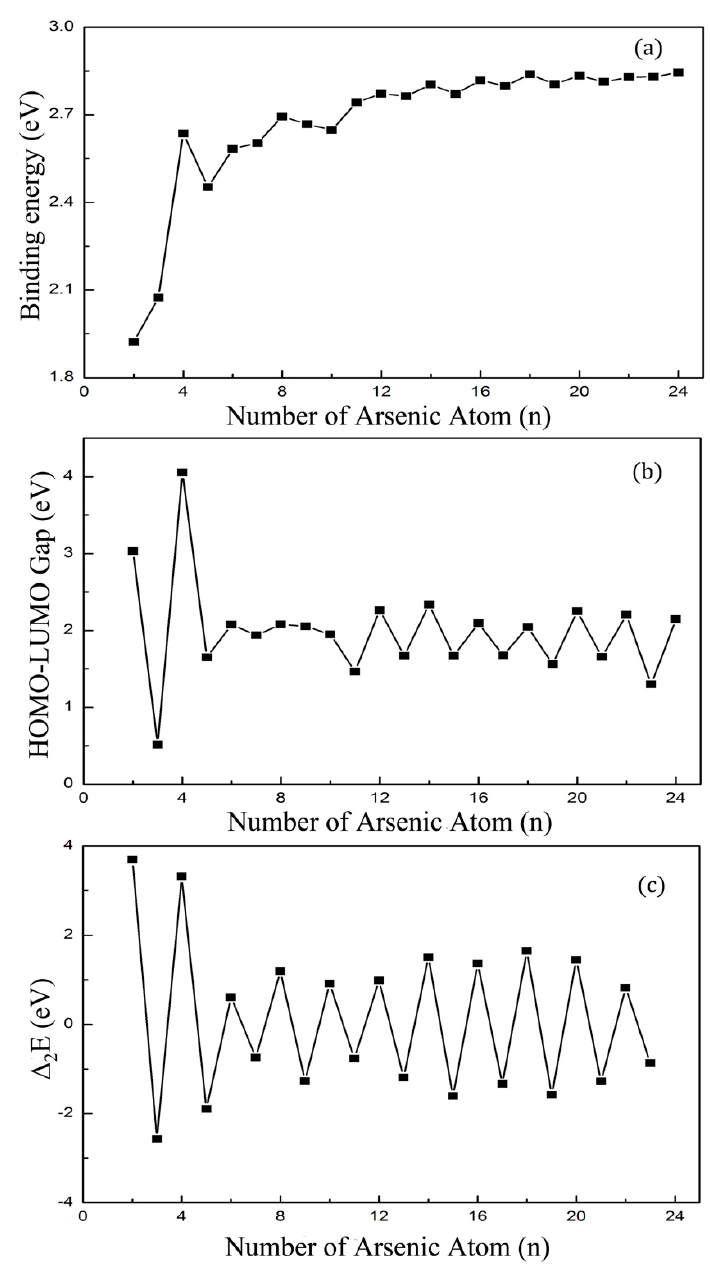
Figure 8. ( a ) Average binding energies ( b ) HOMO-LUMO Gaps and ( c ) second-order difference of cluster energies of As n clusters.